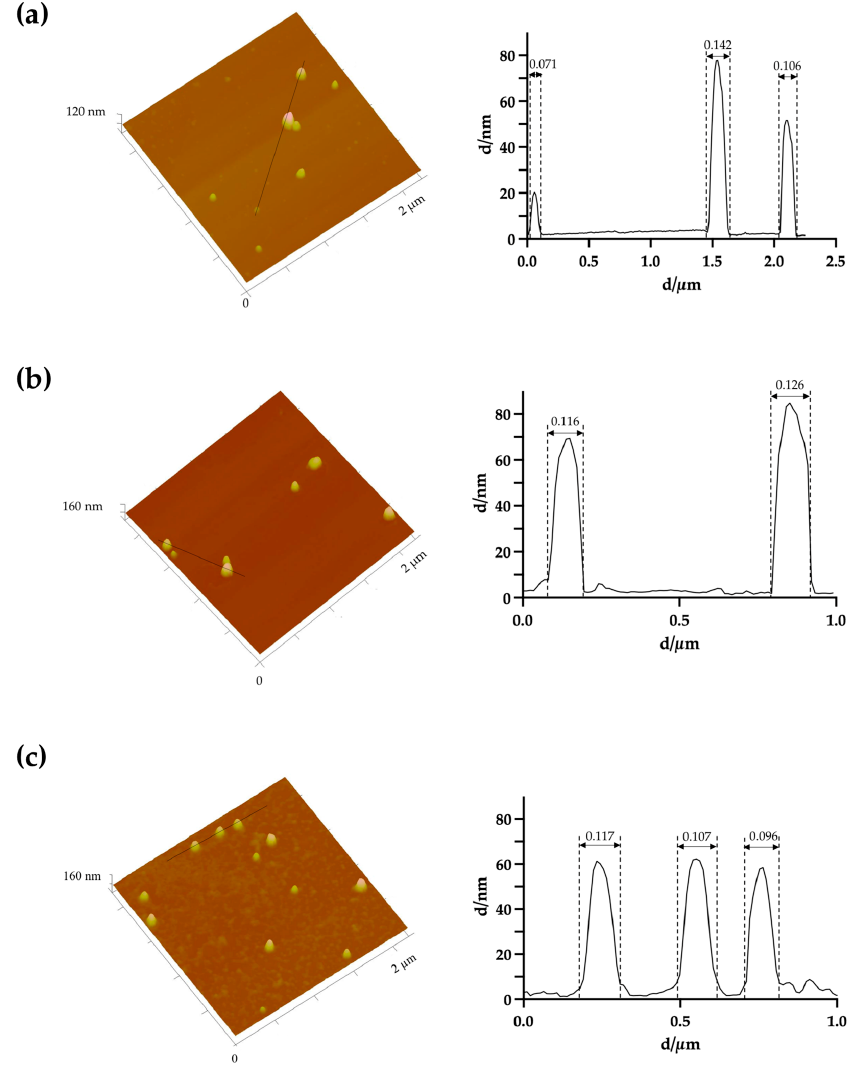
Figure 1. Representative three-dimensional atomic force microscopy images with corresponding cross-section profile of ( a ) uncoated AuNPs, ( b ) HAOA-AuNPs (1:1) and ( c ) BSA-AuNPs (0.25:1). Pharmaceutics 2023 , 15 , 1120